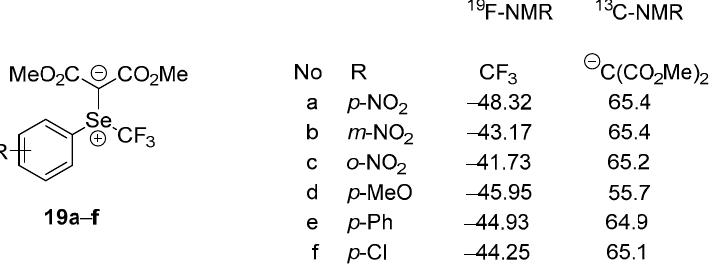
Figure 13. r 13 C r and 19 F chemical shift of selenonium ylides 19a – f .